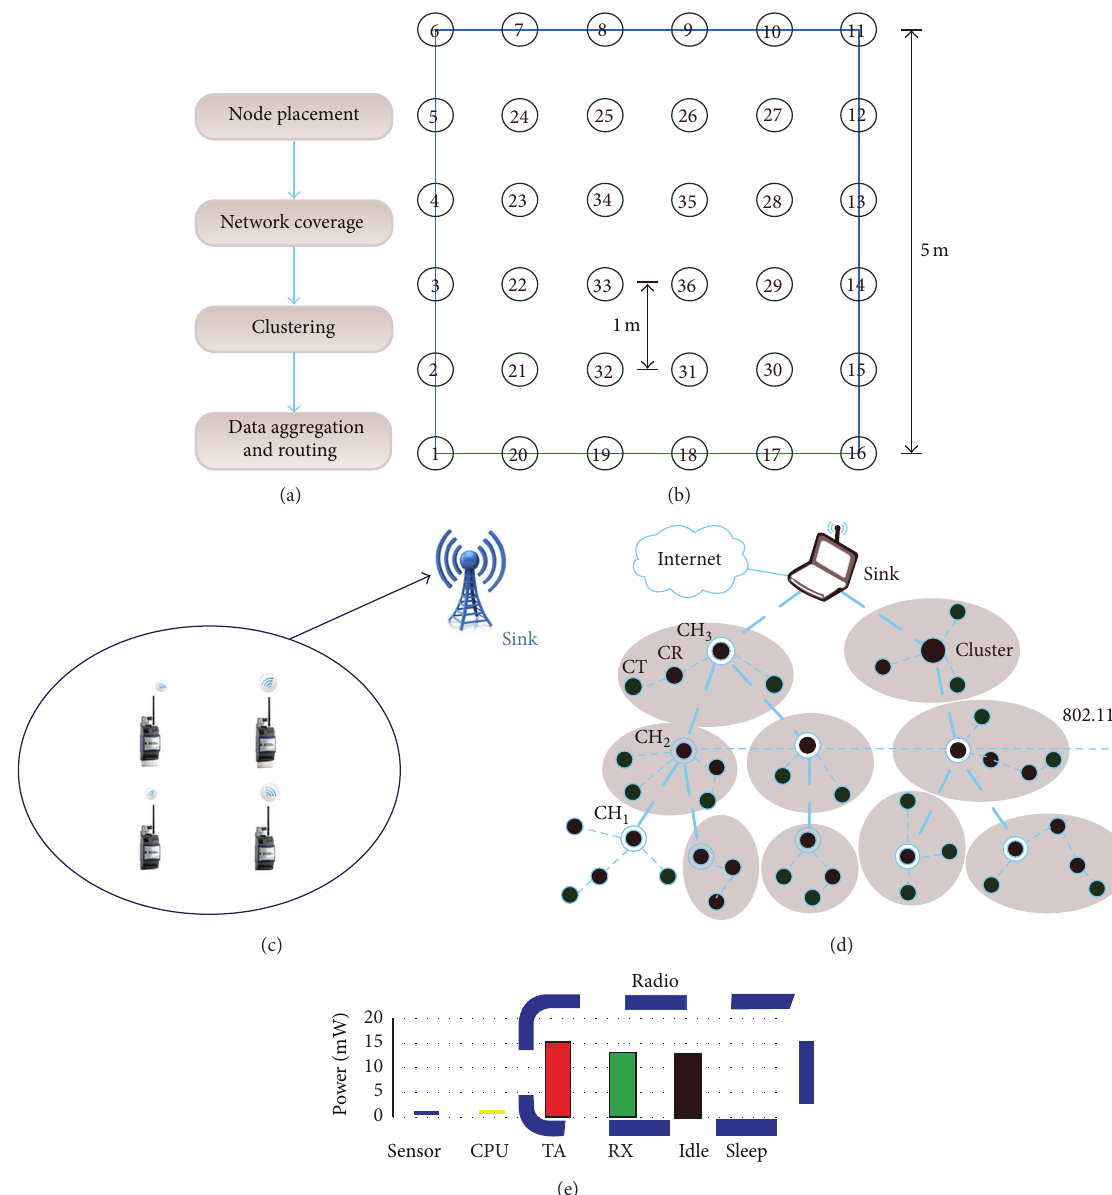
Figure 1: (a) Main operatioanl stages of WSNs. (b) Grid layout of WSN. (c) Network coverage stage. (d) Clustering in WSNs. (e) Energy consumption in different states of